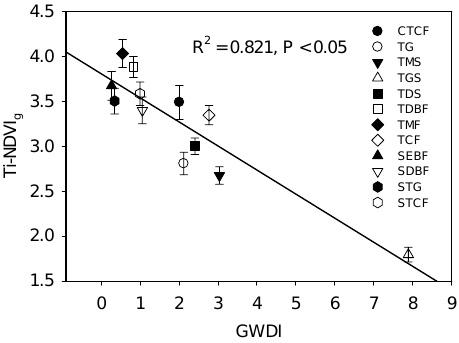
Fig. 8. Relationship between time-integrated growing season NDVI (TI-NDVI g ) and growing season water deficit index (GWDI). Data are spatial averaged by vegetation type for the period